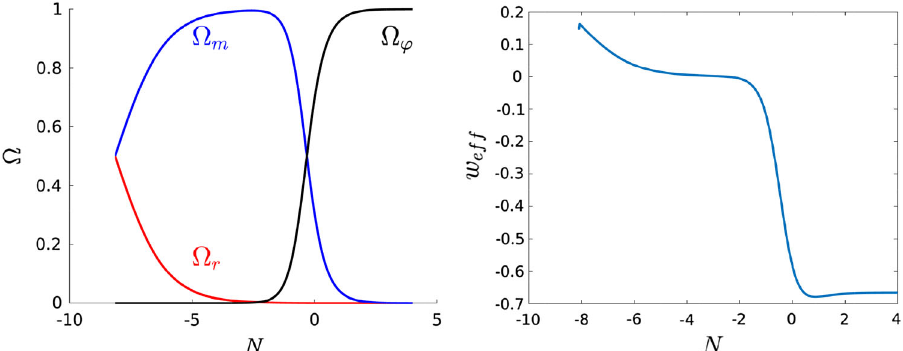
(cid:14) 0 . 3, (cid:13) (cid:14) 0 . 0 and w (cid:14) − 0 . 6. At late time (cid:13) ϕ (cid:14) 0 . 7, (cid:13) m rad ef f they tend to 1 , 0 , 0 and − 0 . 66 respectively. From the plot of w ef f one can see that after the matter-radiation equality the universe enters in a matter domination era, (i.e., w ef f = 0), and finally enters into the current accelerating stage of the universe